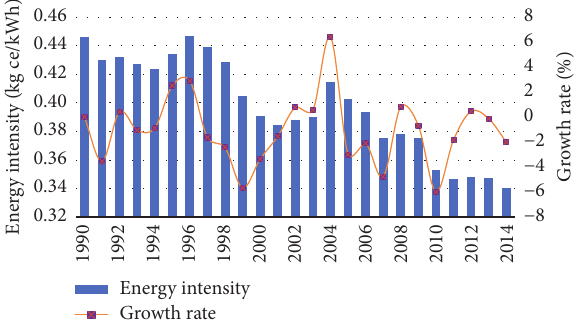
Figure 6: Energy intensity in China’s power sector during 1990–